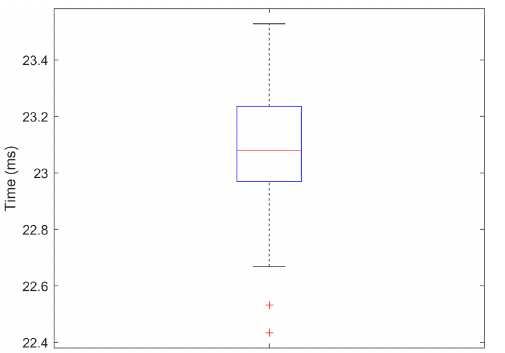
Figure 23. Time value distribution for each frame analysis (signal processing